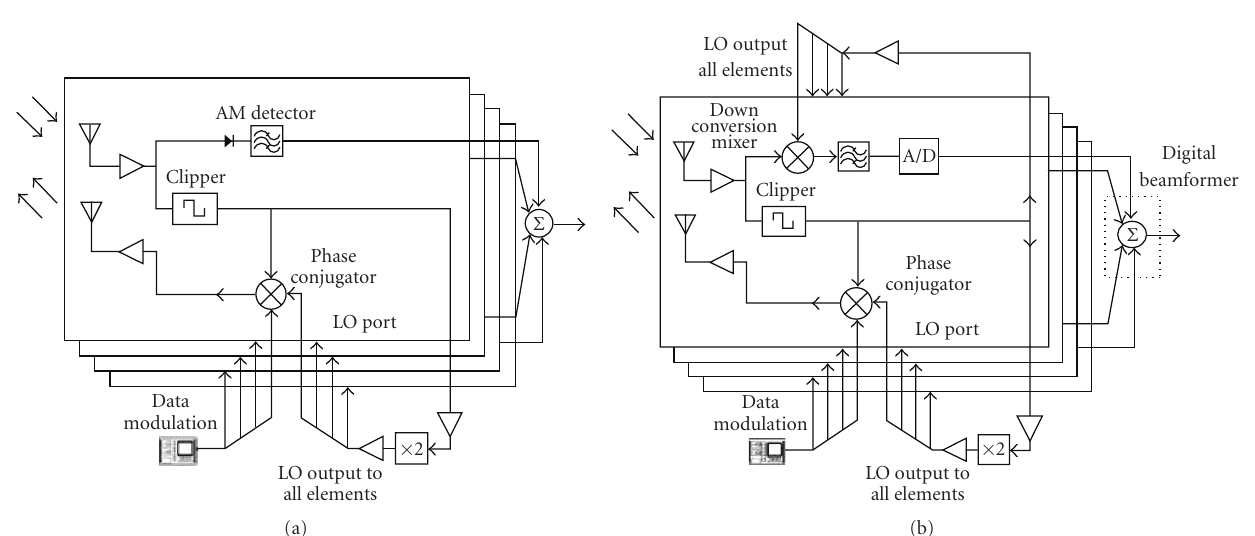
Figure 8: Schematic diagram of a multielement retrodirective transceiver. (a) AM diode detector receiver, (b) DBF